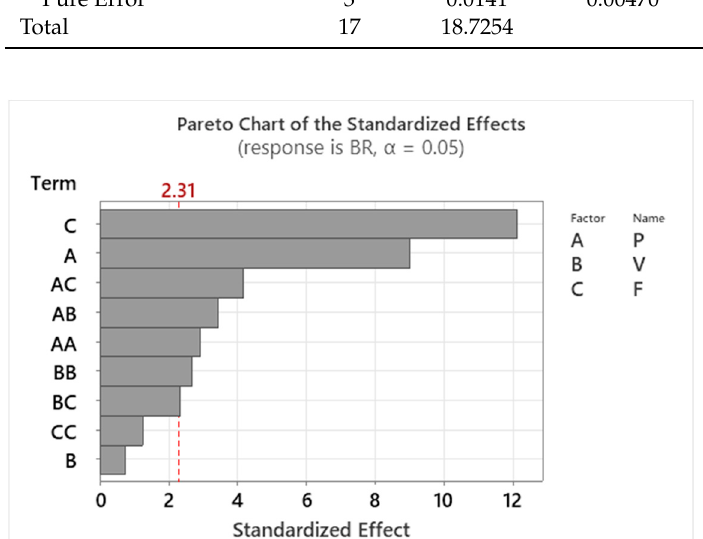
Figure 8. Pareto chart (significance level, α = 0.05) of the standardized effects of process parameters on BR.